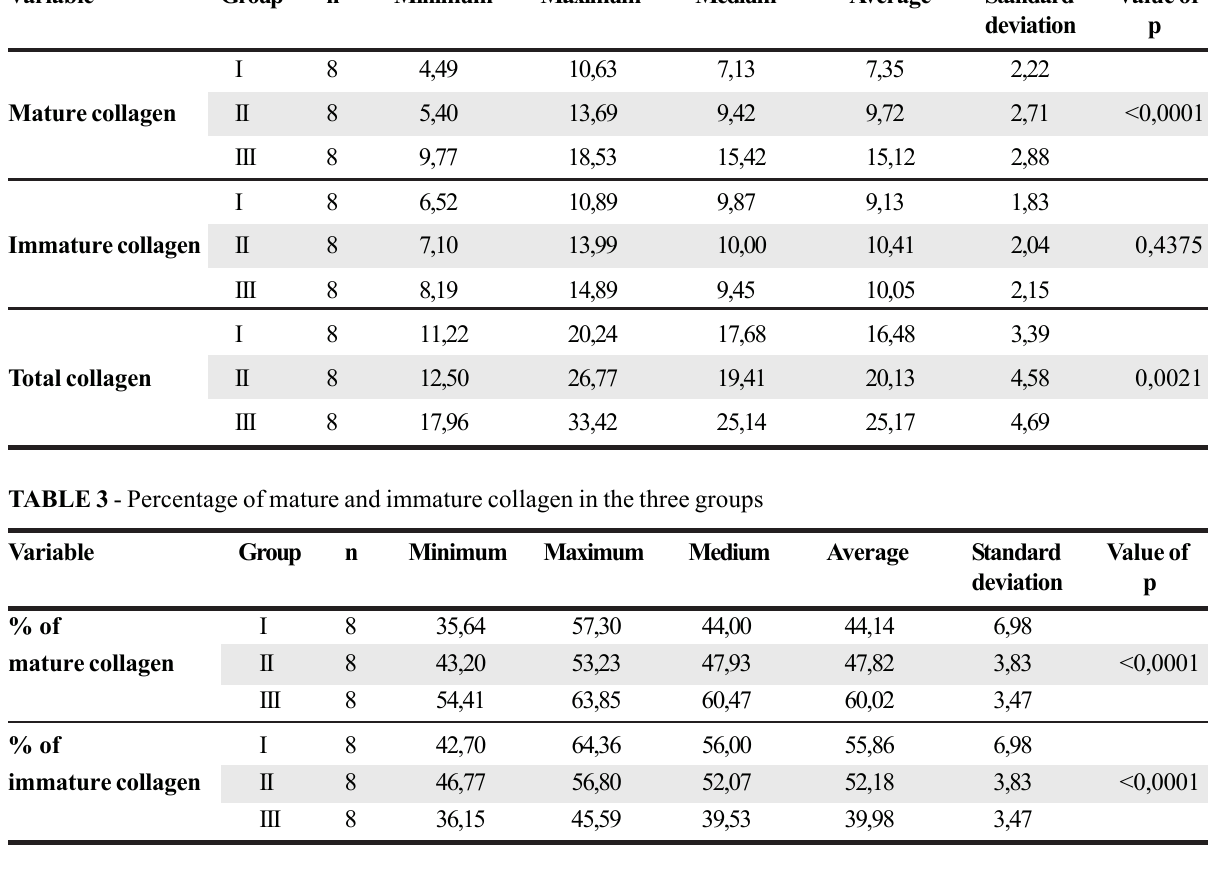
Mature collagen